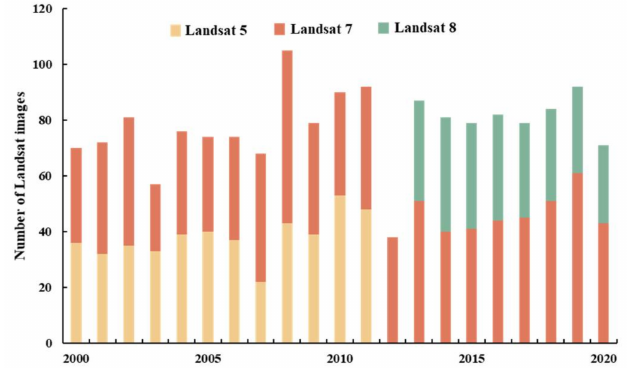
Figure 2. The number of Landsat